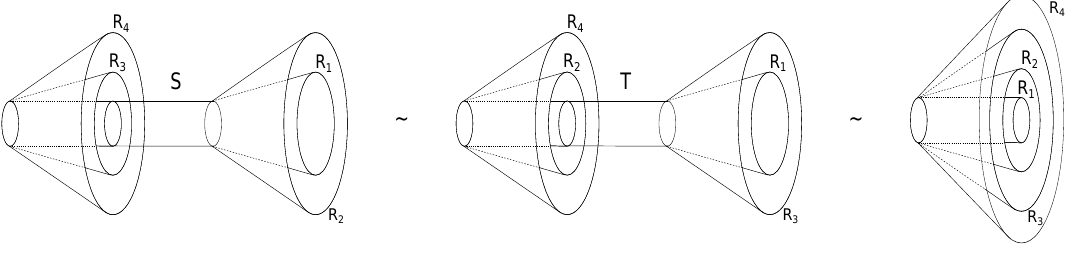
Figure 6 . S n TFT2 for Kronecker coe(cid:14)cients: factorization equation (3.9) or (5.10)